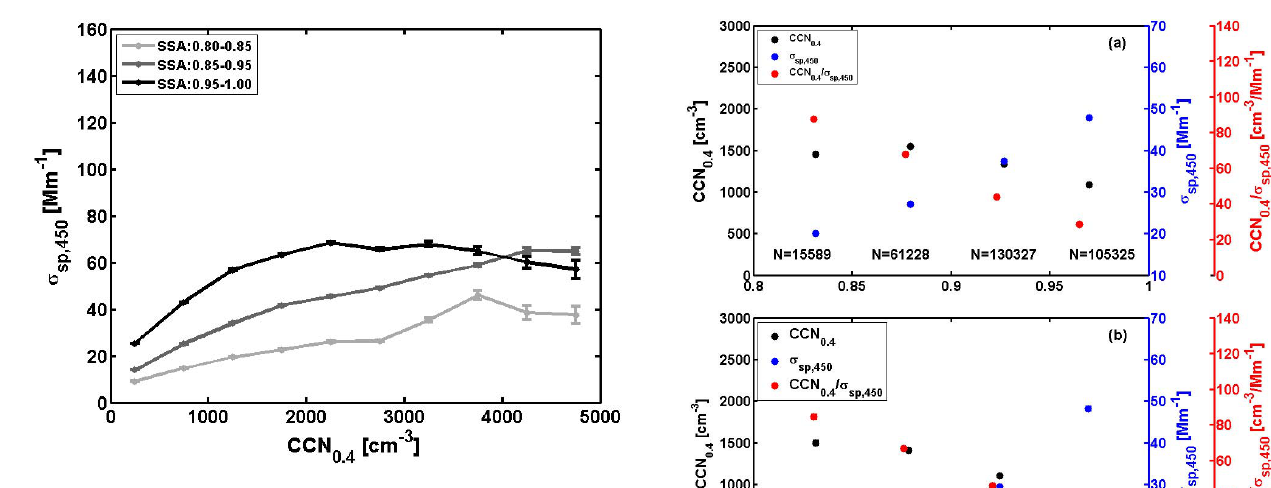
Fig. 7. Relationship between aerosol scattering coefficients at 450nm and CCN 0 . 4 concentrations for different ranges of SSA and for dry particles with D P ≤ 1µm.